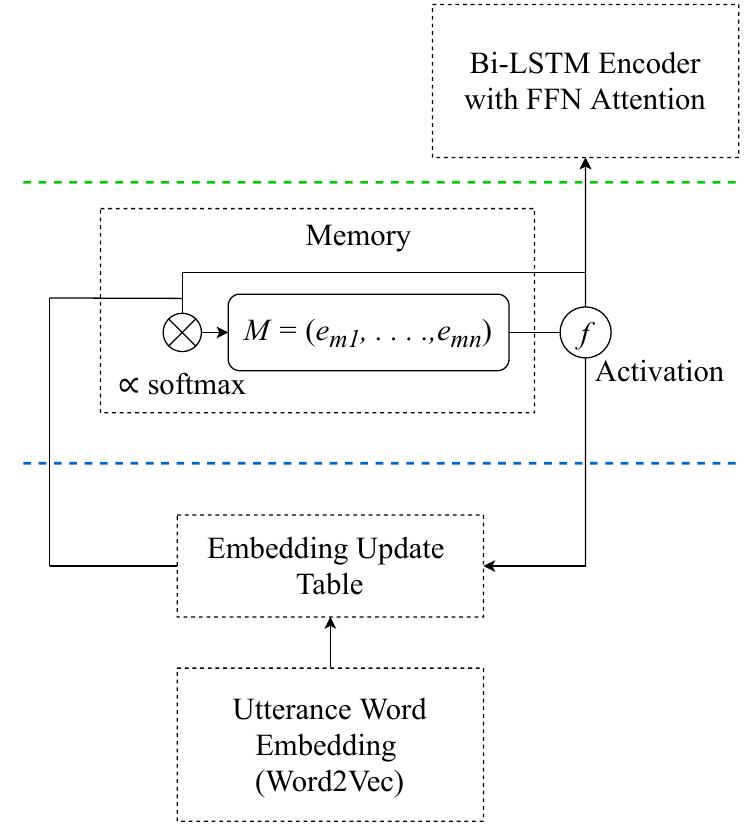
Figure 3. Storage system concept of the memory